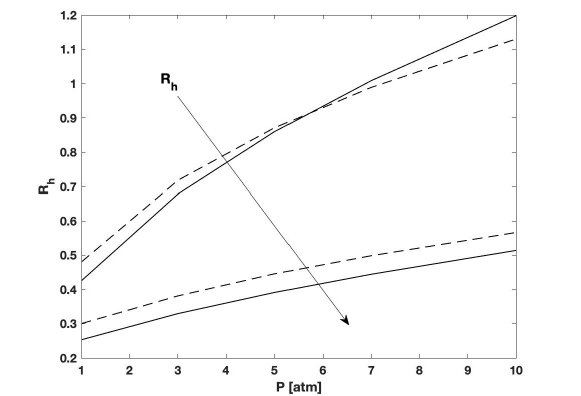
Figure 4. Hydrogen recoveries evaluated from the simplified 2D (solid curves) and 1D (dashed curves) models at Pe = 100, P = 10 atm and temperatures of 600 and 700 ◦